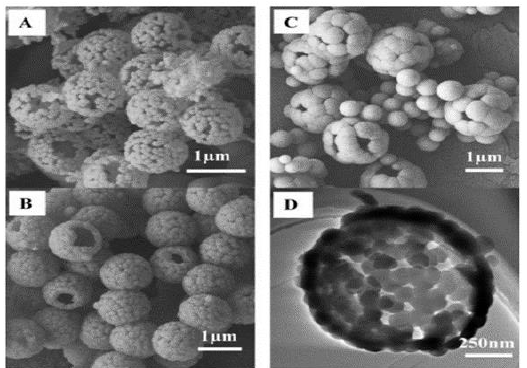
Figure 17. SEM images of hollow silica at pH 10 at different TEOS concentrations: ( A ) 0.06 M, ( B ) 0.12 M, ( C ) 0.24 M. ( D ) TEM of hollow silica spheres achieved at a TEOS concentration = 0.12 M [61].